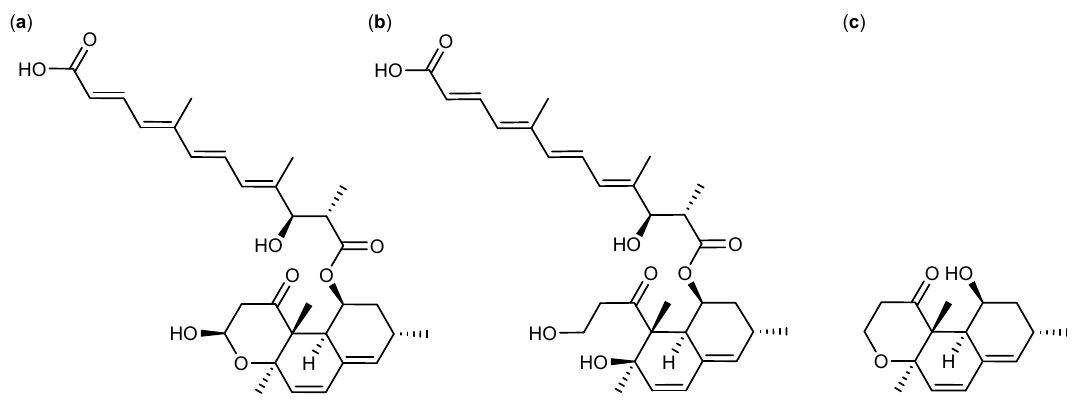
Figure 5. Structure of ( a ) Calbistrin A, ( b ) Calbistrin C, and ( c ) Versiol.